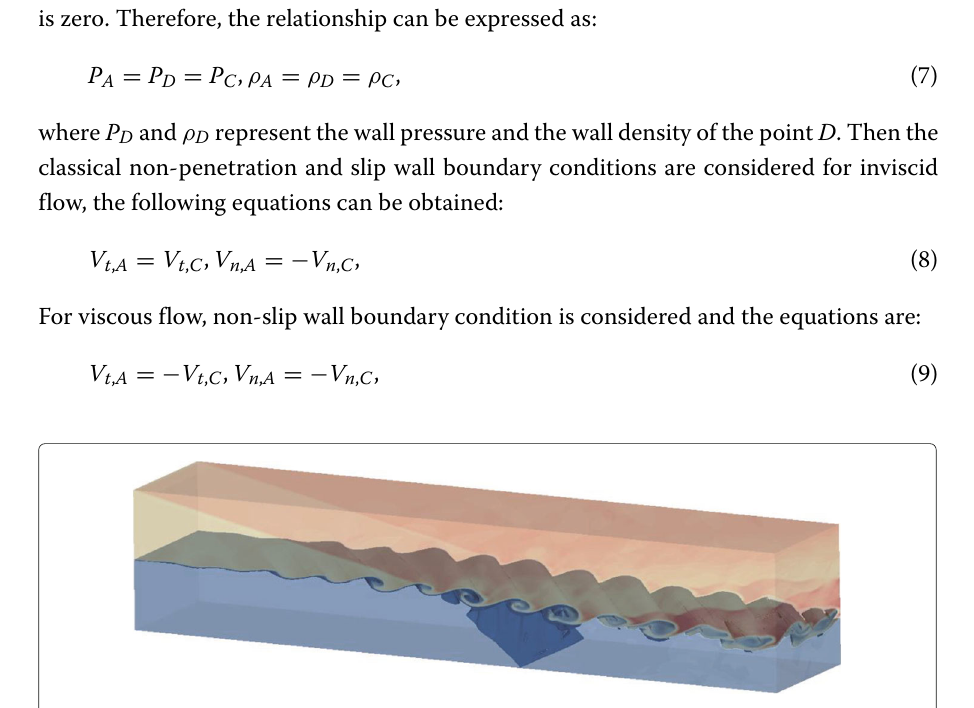
Fig. 10 Density contours of three-dimensional viscous shock-mixing layer problem on adaptive Cartesian grids. T =